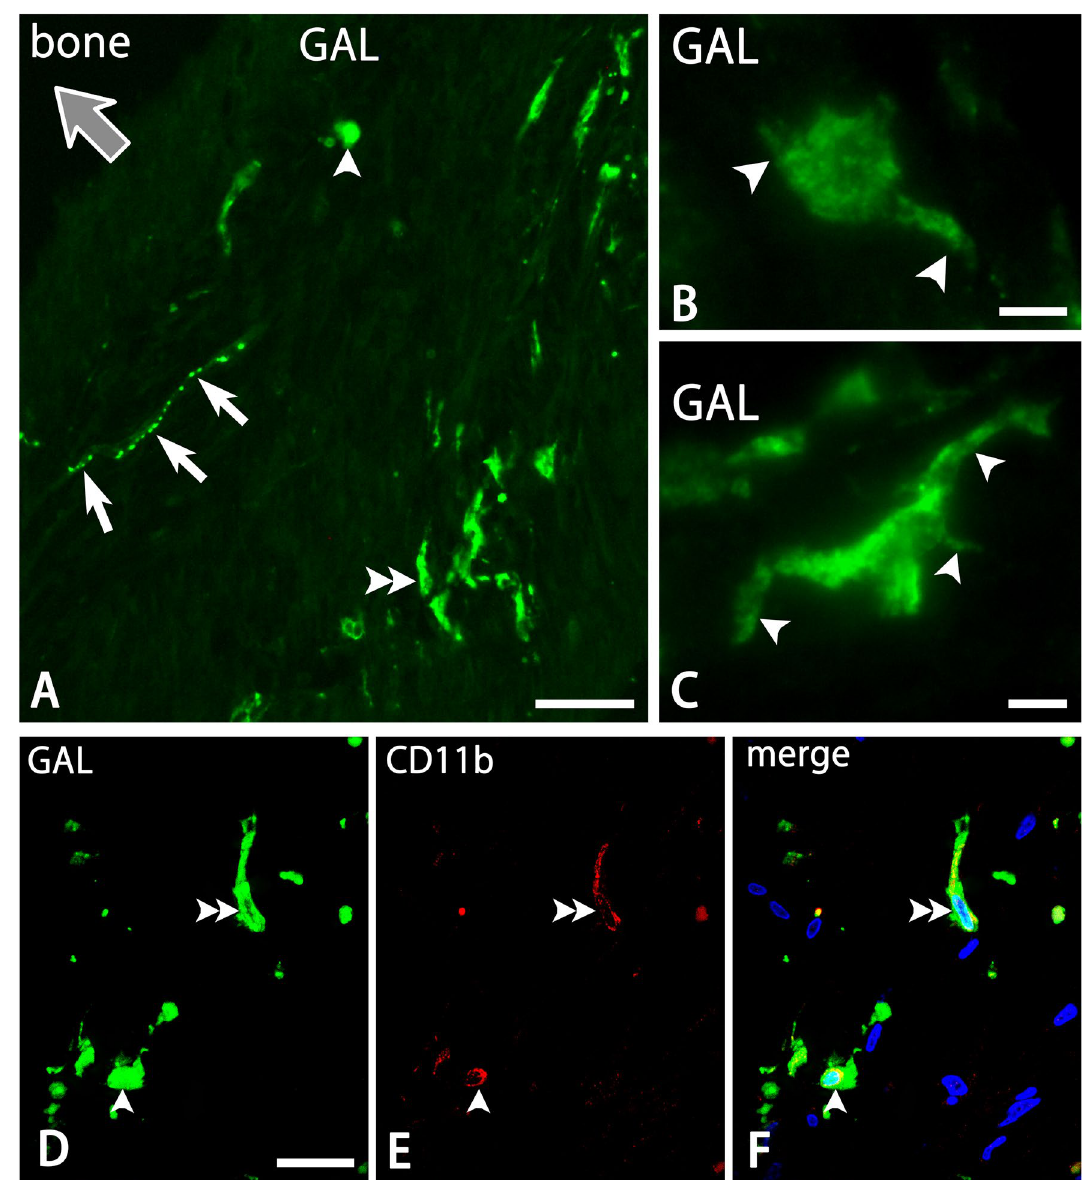
Figure 2. Photomicrographs for GAL ( A – D , F ), CD11b ( E , F ) and DAPI ( F ) in the cerebellar tentorium by a conventional fluorescence microscope ( A – C ) and a confocal laser scanning microscope. Panels ( D – F ) are from the same field of views. GAL-immunoreactivity is expressed by round (an arrowhead) and oblong cells (a double arrowhead), and varicose nerve fibers (arrows) in the thick dura mater ( A ). Gray arrows indicate the direction toward the bone ( A ). Panels ( C ) and ( D ) show round and oblong types, respectively, of GAL-ir cells with some processes (arrowheads). GAL- and CD11b-immunoreactivity are co-expressed by round (arrowheads) and oblong (double arrowheads) cells ( D – F ). Bars = 50 µm ( A ), 20 µm ( D ) and 10 µm ( B , C ). Panels ( D – F ) are at the same